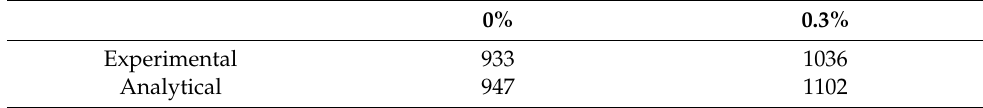
Table 3. Comparisons of critical loads for simple–simple CNTRC beams.